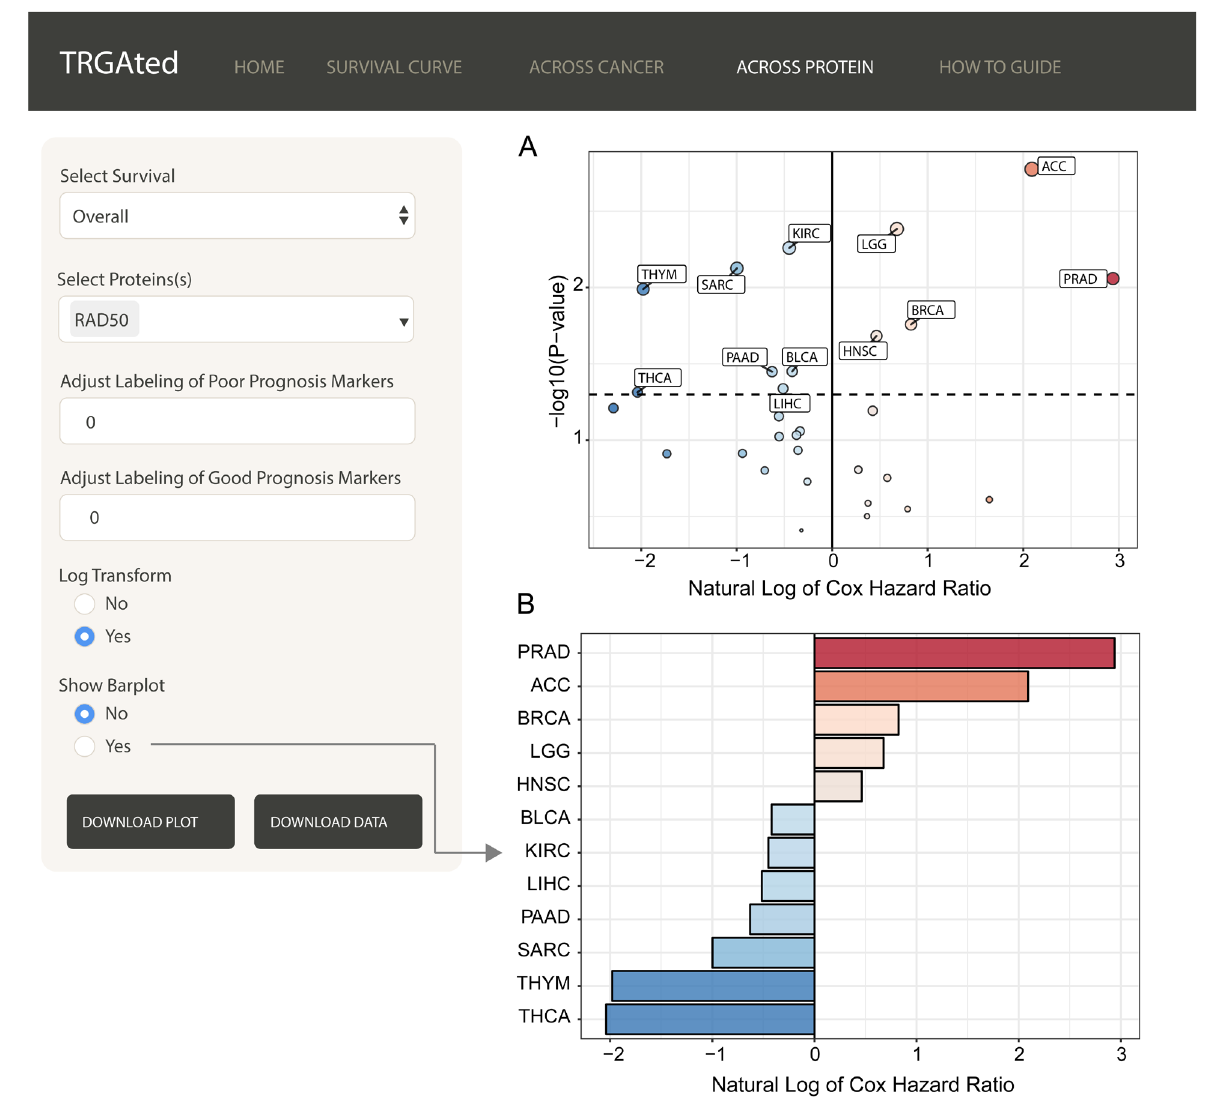
Figure 4. Visualizing all proteins across a single cancer type. The interface shows an example of the visualization of Cox hazard ratio of for RAD50 across all 31 cancer types ( A ). This feature is similar to the Across Cancer tab with the ability to adjust labels and log-transform the Cox hazard ratios. Additionally, the hazard ratios for significant cancer types can be visualized using a bar chart ( B